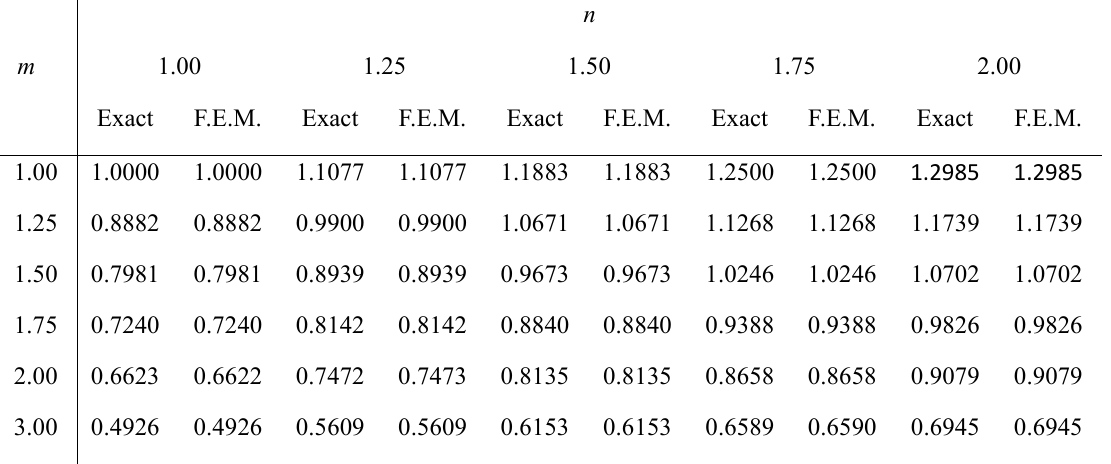
Comparison of the buckling load factor A column ( 